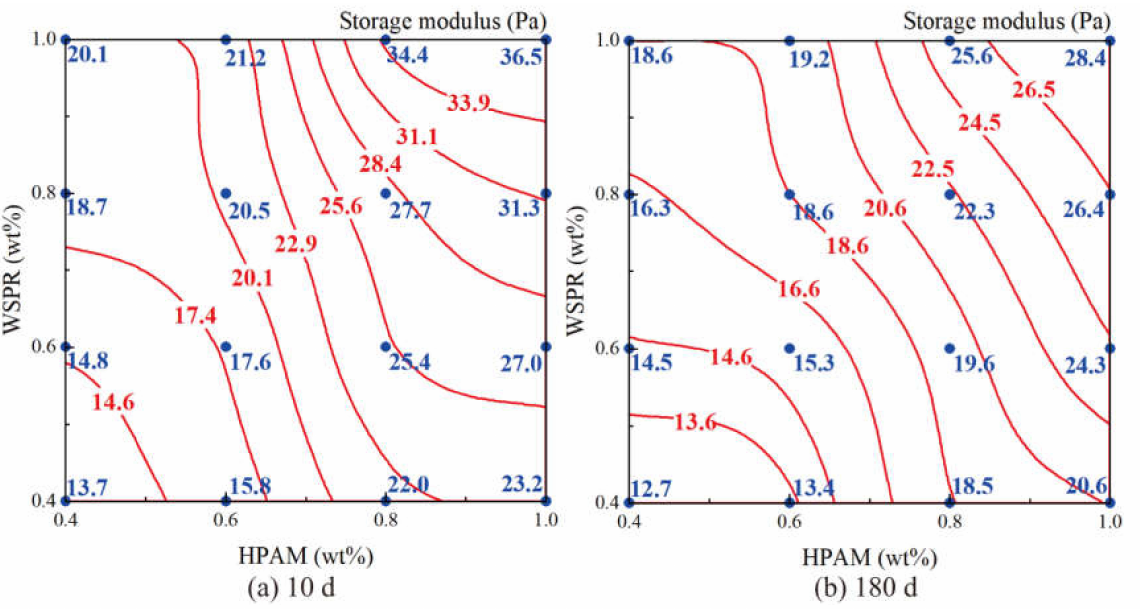
Figure 4. Strength isogram of different component gels aged at 110 ◦ C for different times: ( a ) Strength of gels aged at 110 ◦ C for 10 days; ( b ) Strength of gels aged at 110 ◦ C for 180